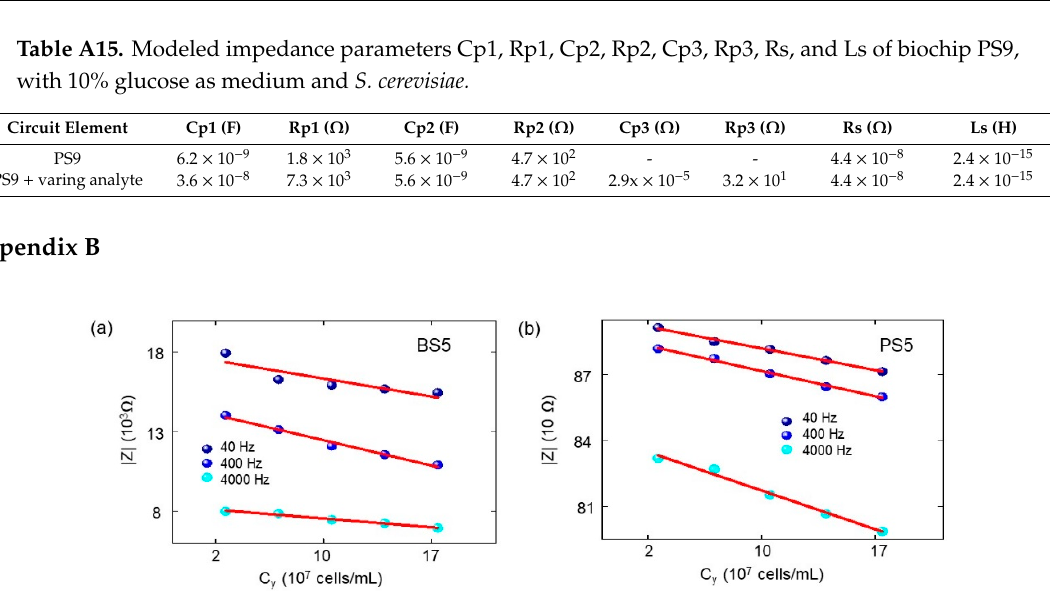
Figure A1. Impedance measured at a test frequency of 40 Hz, 400 Hz and 4000 Hz of biochip ( a ) BS5 (Table A16) and of biochip ( b ) PS5 (Table A17) in dependence on the yeast concentration c y in DI water. Table A16. The impedance amplitude for boron doped biochip BS5 with the analyte at 40 Hz, 400 Hz, and 4 kHz (Figure